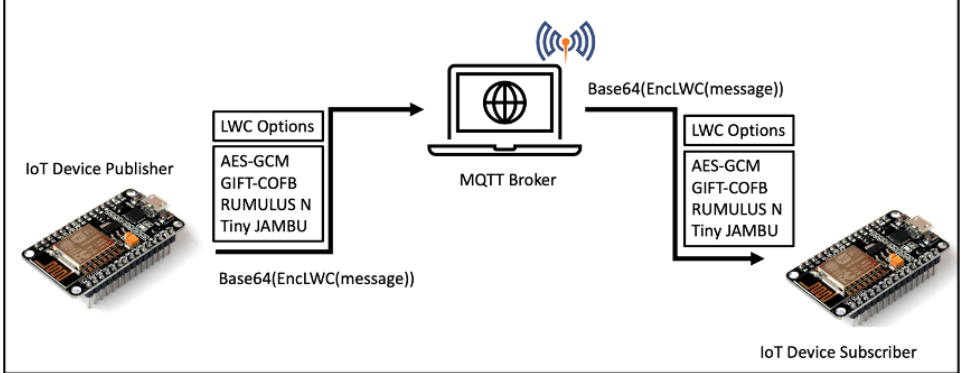
Figure 5. Secure MQTT Implementation Scheme with LWC.